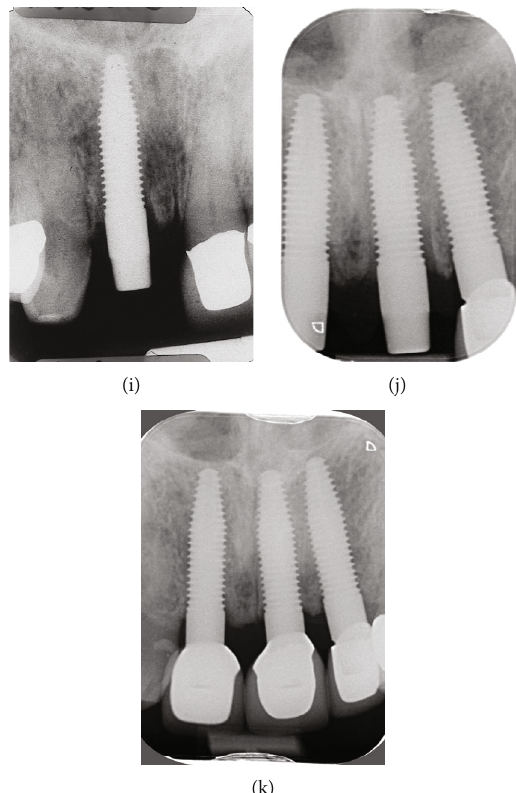
Figure 7: Immediate restoration of one-piece implant in esthetic zone: (a) clinical situation after fracture of left central incisor, (b) atraumatic extraction of remaining tooth, (c) complete extraction and cleaning of alveolar ridge, (d) clinical situation after immediate implant placement, (e) provisional restoration, reattachment of implant crown for right central incisor, (f) prosthetic restoration with single crown fi ve months after healing, (g) initial radiographic situation with hopeless right central incisor, (h) radiographic situation before implantation of left lateral incisor, (i) radiographic control after implantation of fi rst right incisor, (j) radiographic control after immediate implantation of left central incisor, and (k) radiographic situation nine months after immediate implant placement for left central